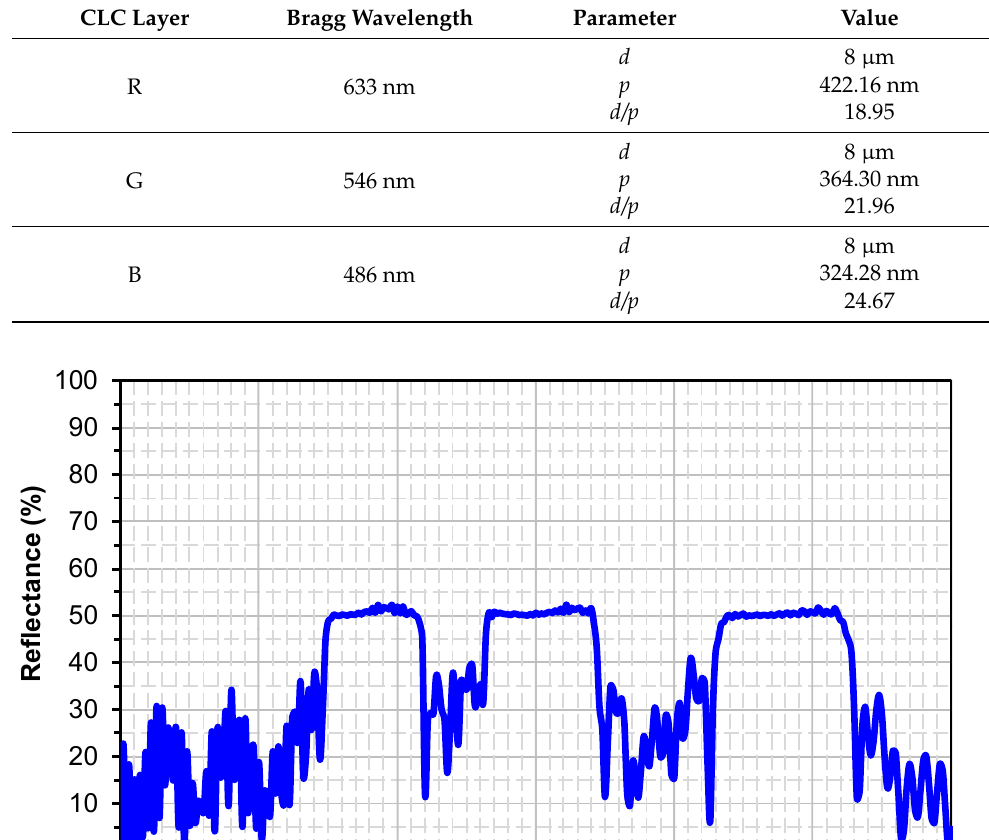
Figure 7. Reflectance with respect to the incident angle. The angular bandwidth of reflectance from 45% to 50% for R/G/B is 50/52/52 degrees, which is wide enough to cover half of the FOV. 3.3. Uniformity With VirtualLab Fusion, the location of duplicated exit pupils can be obtained by tracing the rays of central field, as shown in Figure 8, where the entrance pupil is circular and 4 mm across. In order for the duplicated pupils to be uniform, by setting the uni- formity error of the detector as the merit function and employing the Nelder–Mead or downhill simplex method, the normalized grating efficiencies of the reflected zeroth (R0) and first (R1) orders are tweaked as in Table 3. The uniformity, defined as Uniformity = 2𝐼 (cid:3040)(cid:3036)(cid:3041) 𝐼 (cid:3040)(cid:3028)(cid:3051) + 𝐼 (cid:3040)(cid:3036)(cid:3041)